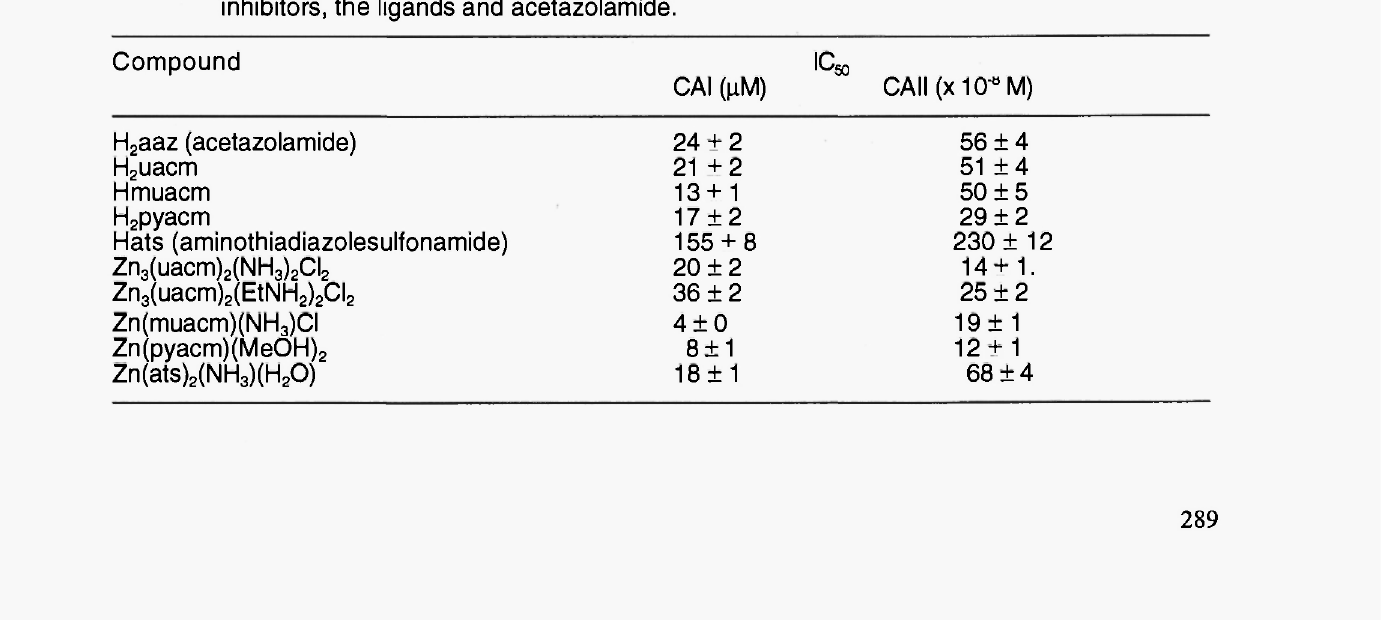
Table VI. Inhibition data (10«, values) against human isozymes CAI and CAN with the complex inhibitors, the ligands and acetazolamide.